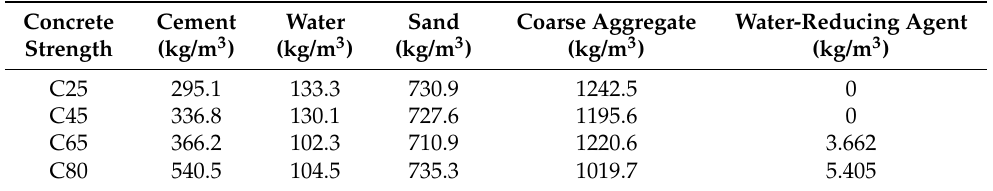
Figure 1. Cross-sectional dimensions of composite beams: ( a ) cross-section; ( b ) longitudinal section. Table 2. Concrete mix Table 1. Main parameters of composite beams.